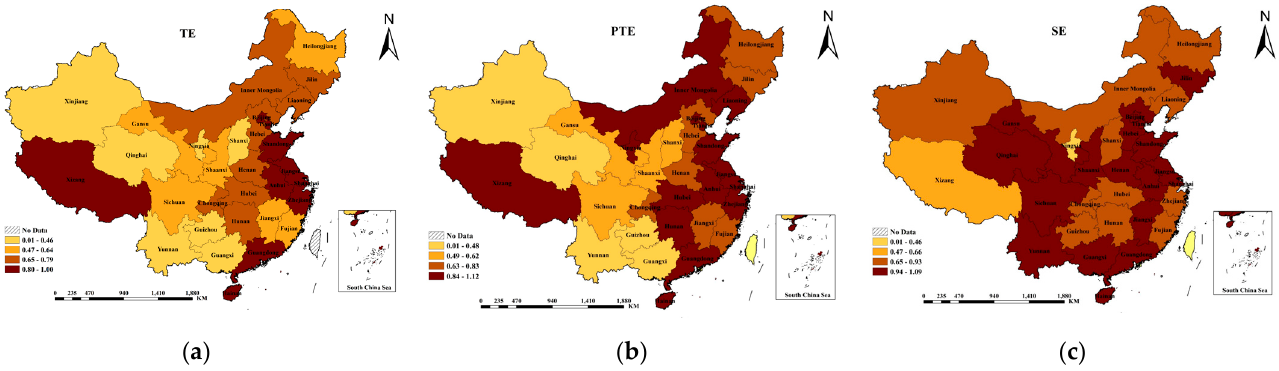
Figure 2. The adjusted technical efficiency and scale efficiency of provincial public sports service adjustment: ( a ) the technical efficiency of each province; ( b ) the pure technical efficiency of each province; ( c ) the scale efficiency of each province.